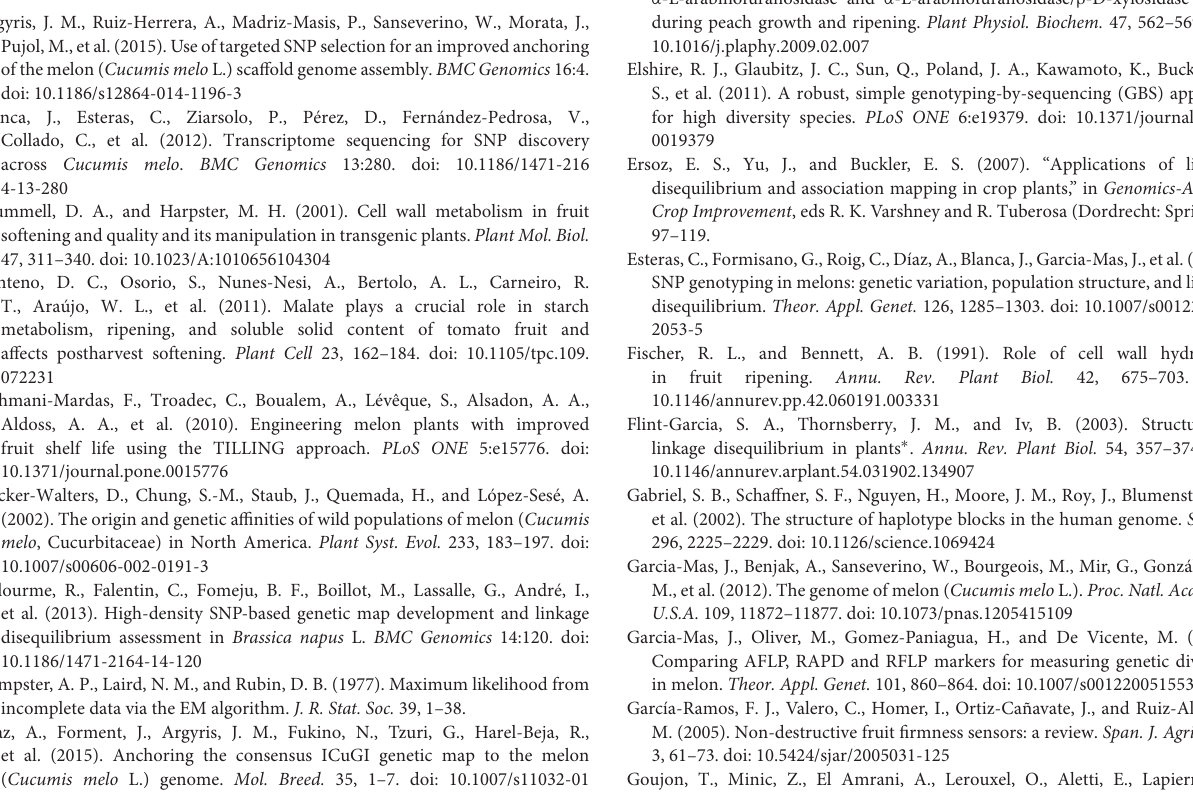
Figure S1 | High resolution genetic map of melon with 7153 loci. Table S1 | List of melon accessions used in the current study. Table S2 | Fruit pressure across various years and locations. Table S3 | Fruit pressure distribution in F2 progeny of a cross of MR-1 ( momordica ) and “Hale’s Best Jumbo” (P2), a Western Shipped Cantaloupe.